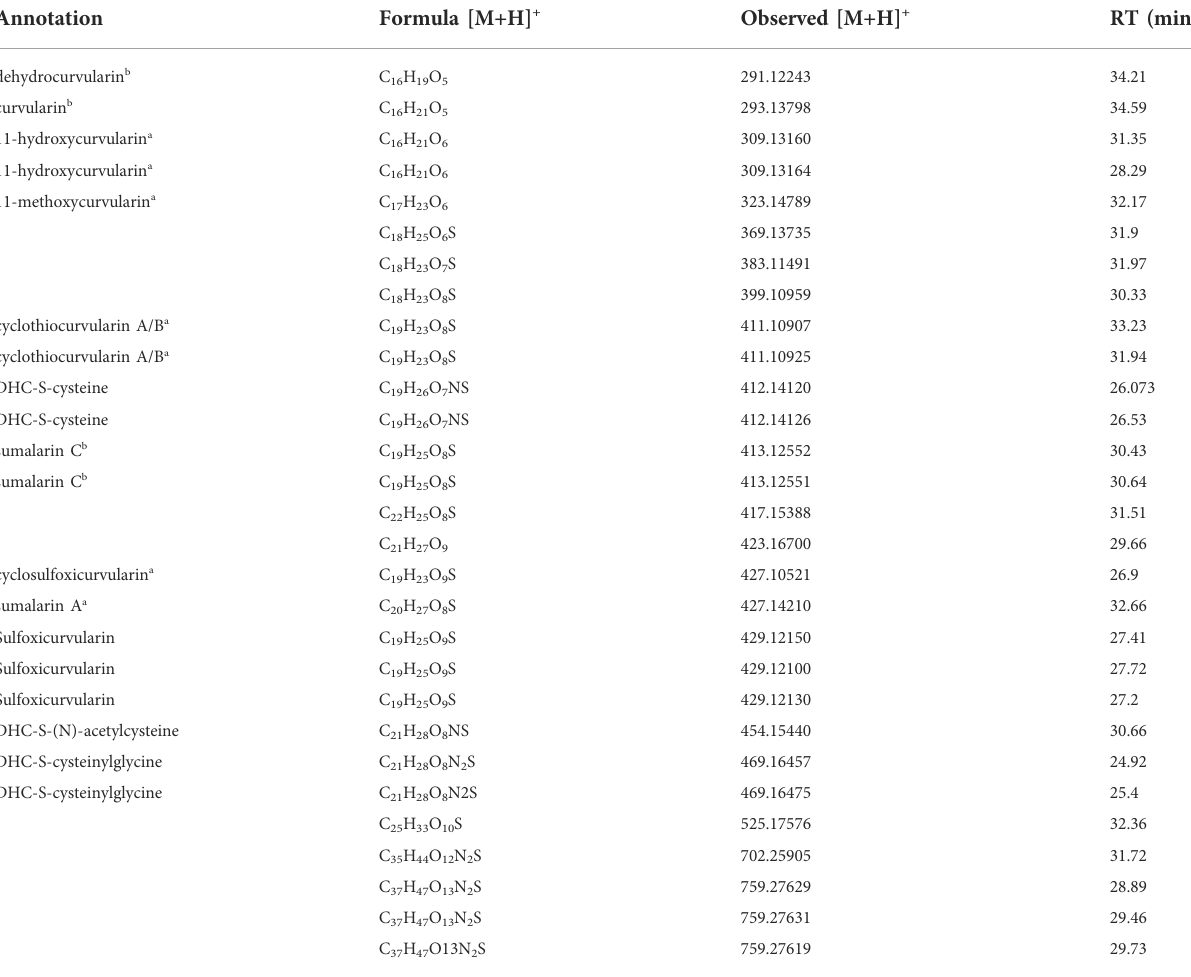
TABLE2Isolate-speci fi cmassfeatureslinkedtodehydrocurvularin(DHC)detectioninthisstudy.Allmassfeaturesare[M+H] + adducts,withobserved m/z detected within 5 ppm accuracy to the exact mass of the predicted chemical formula. Retention times are from the nanoLC-HRMS based analysis of an extract from